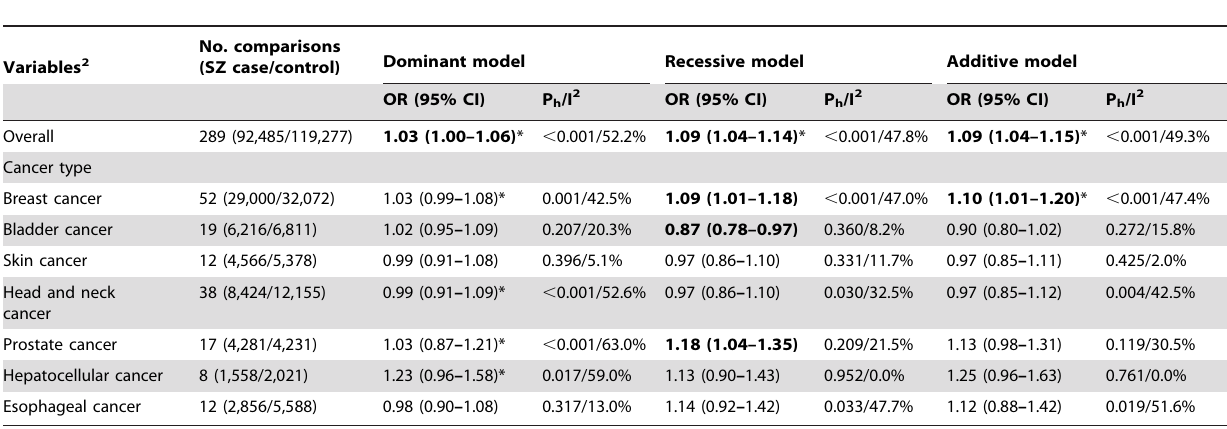
Table 5. Summary ORs (95% CI) and value of the heterogeneity of XRCC1 Arg399Gln polymorphism under different genetic models according to studies with HWE on cancer risk 1